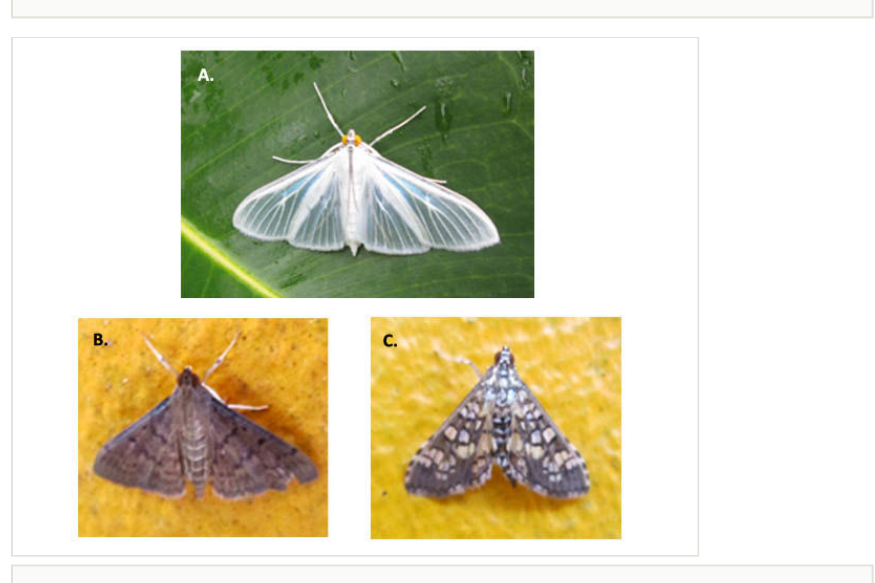
Figure 6. Crambidae: A) Palpita fl egia ; B) Herpetogramma phaeopteralis ; C) Samea ecclesialis